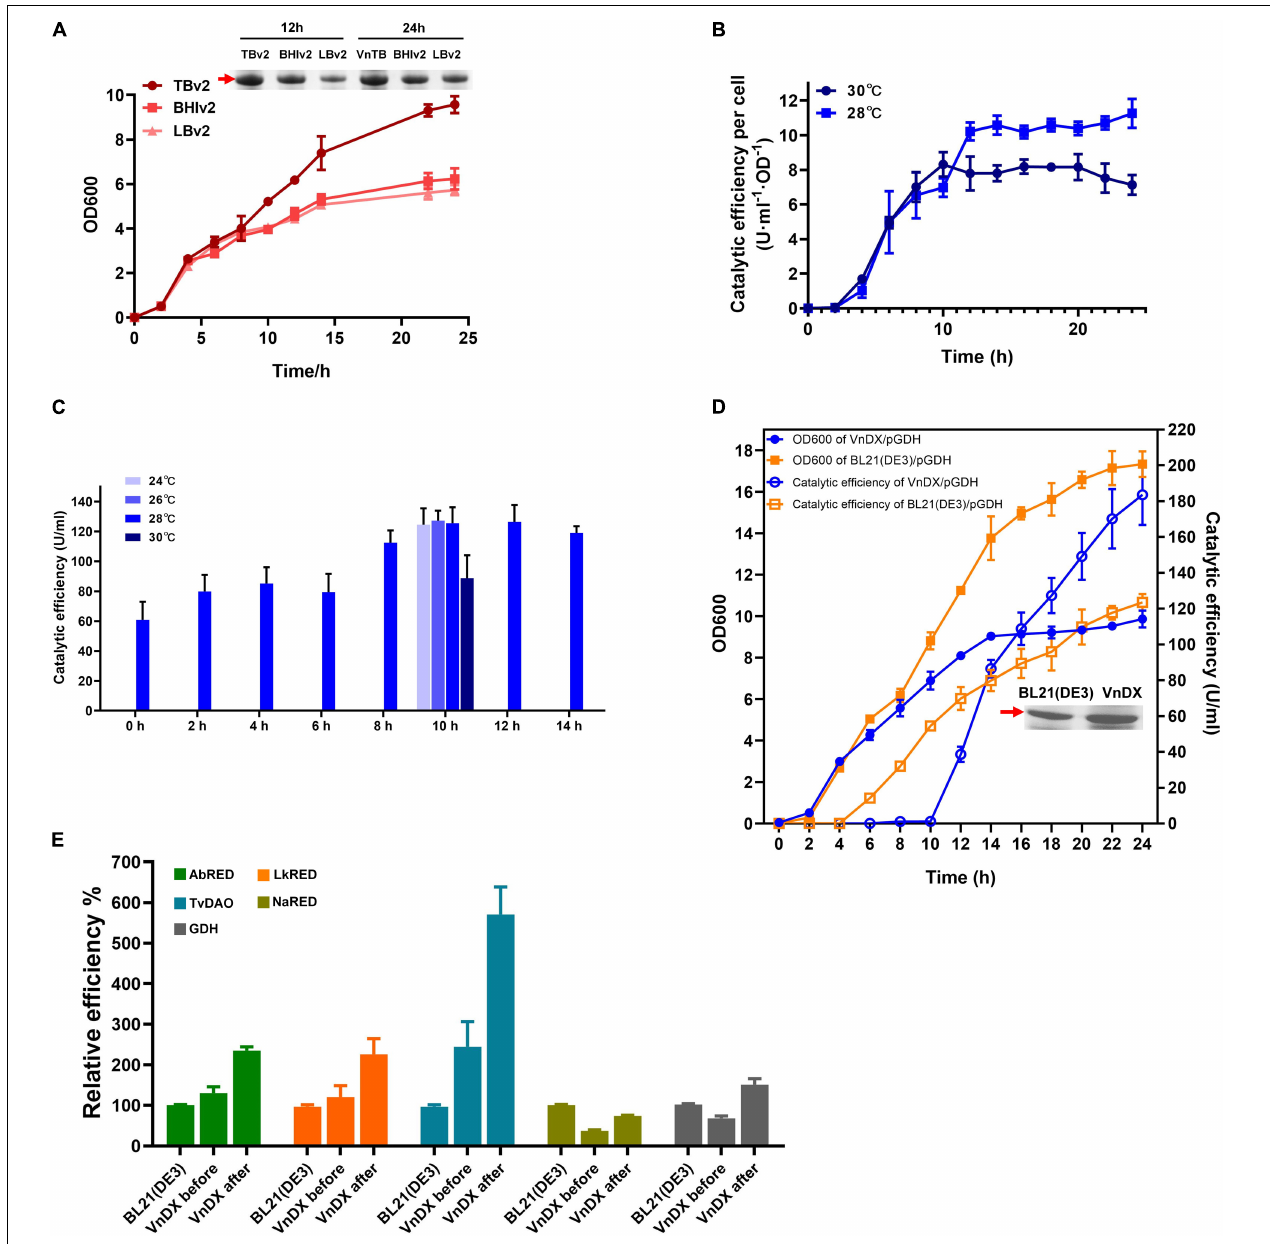
FIGURE 3 | Optimization of “what to try first” protocol for V. natriegens and testing the general applicability of the consensus protocol. (A) Growth curve of VnDX/pGDH in TBv2, BHIv2, and LBv2 medium and sodium dodecyl sulfate polyacrylamide gel electrophoresis (SDS-PAGE) analysis of soluble glucose dehydrogenase (GDH) in 12 and 24 h. Here, 0.075 OD 600 crude protein samples were loaded for SDS-PAGE. (B) The curve of GDH catalytic efficiency per OD 600 [U/(ml · OD)] at 28 or 30 ◦ C. Induction occurred at 0 h. (C) Optimization of induction point and temperature of VnDX/pGDH. (D) Compare growth and catalytic efficiency of GDH between VnDX and BL21(DE3) under consensus “what to try first” fermentation conditions. (E) Five genes of interest (GOIs) were tested for the general applicability of the “what to try first” protocol. AbRED, carbonyl reductase from Acinetobacter baylyi CIBT3993; LkRED, carbonyl reductase from Lactobacillus kefiri CIBT3995; TvDAO, D-amino acid oxidase from Trigonopsis variabilis CIBT4021; NaRED, carbonyl reductase from Novosphingobium aromaticivorans DSM 12444 CIBT3990; GDH, glucose dehydrogenase from Bacillus subtilis . BL21(DE3), the optimal fermentation condition for E. coli BL21(DE3); VnDX before, V. natriegens fermentation condition before optimization; VnDX after, the fermentation condition using our improved “what to try first” protocol. Error bars represent the SD of n = 3 technical replicates.